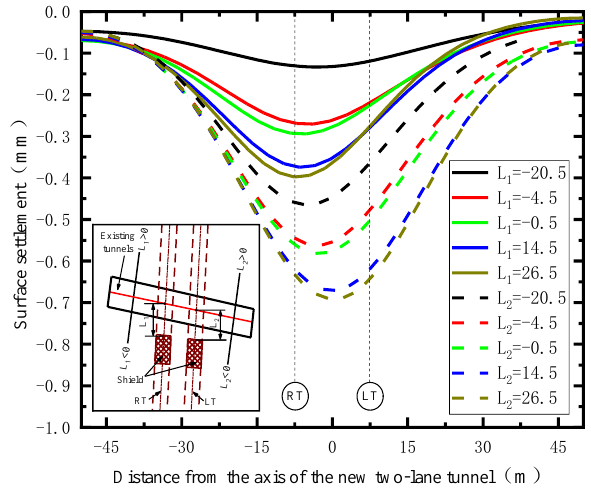
Figure 9. Ground settlement above the existing tunnel axis is caused by tunnel excavation.